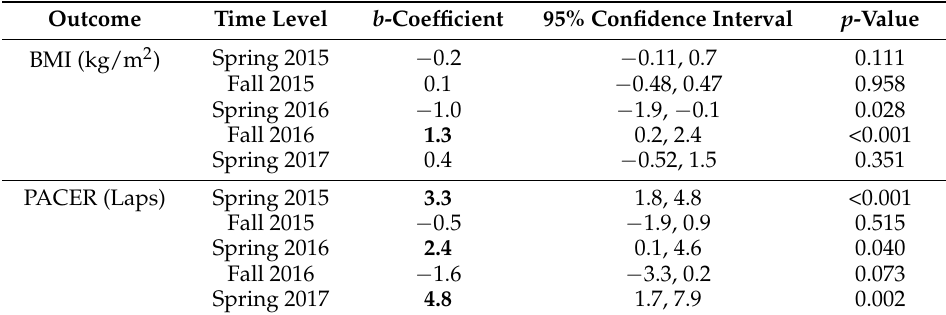
Table 2. Time effect parameter estimates from the BMI and PACER general linear mixed effects models ( n = 404). Outcome Time Level b -Coefficient 95% Confidence